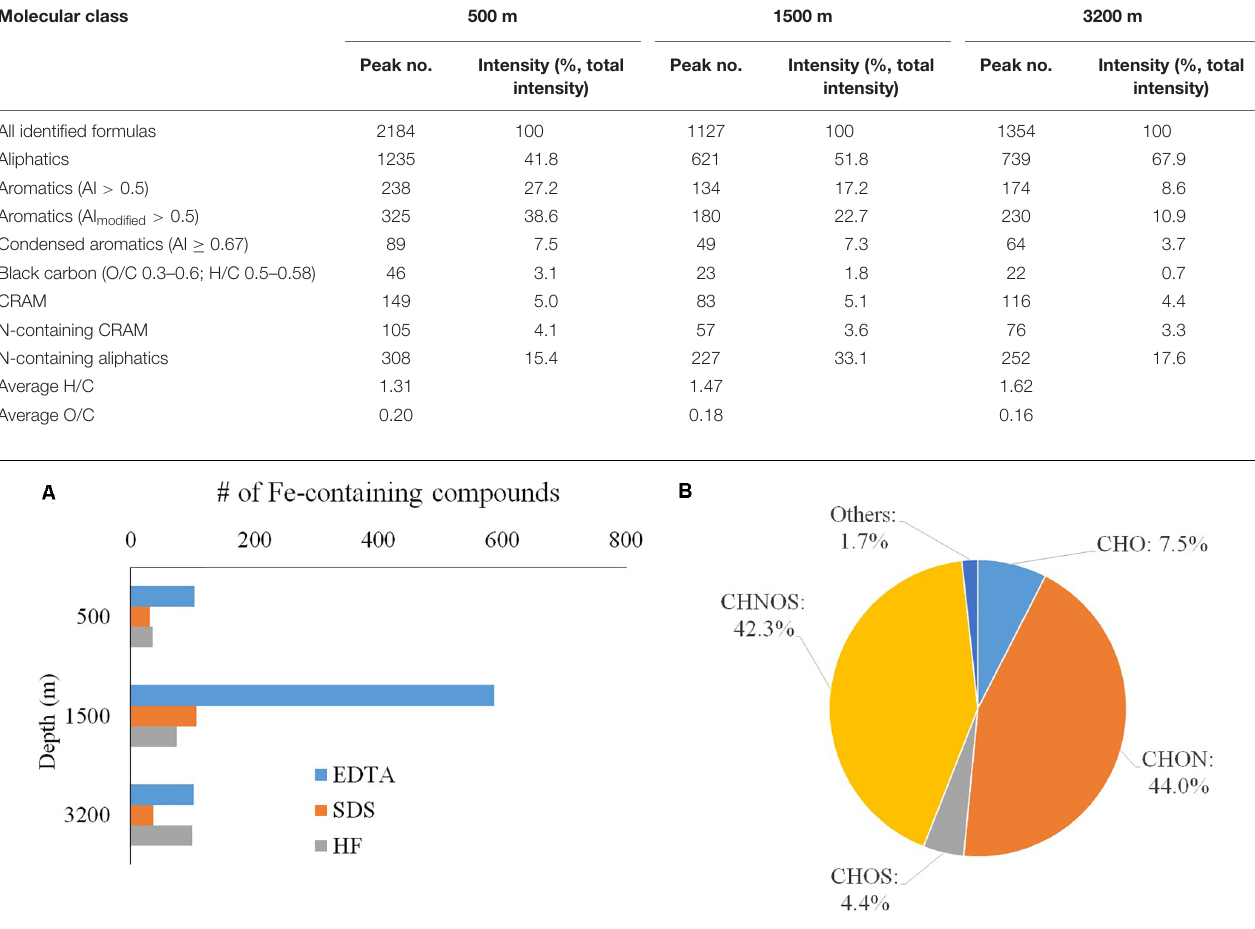
TABLE 2 | Compound classification of assignable peaks at different depths (CRAMs were defined as molecules having DBE: C 0.30–0.68, DBE: H 0.20–0.95, and DBE: O 0.77–1.75; average H/C and O/C are calculated as intensity-normalized average values). Molecular class 500 m 1500 m 3200 m Peak no. Intensity (%, total Peak no. Intensity (%, total Peak no. Intensity (%, total intensity) intensity) intensity)